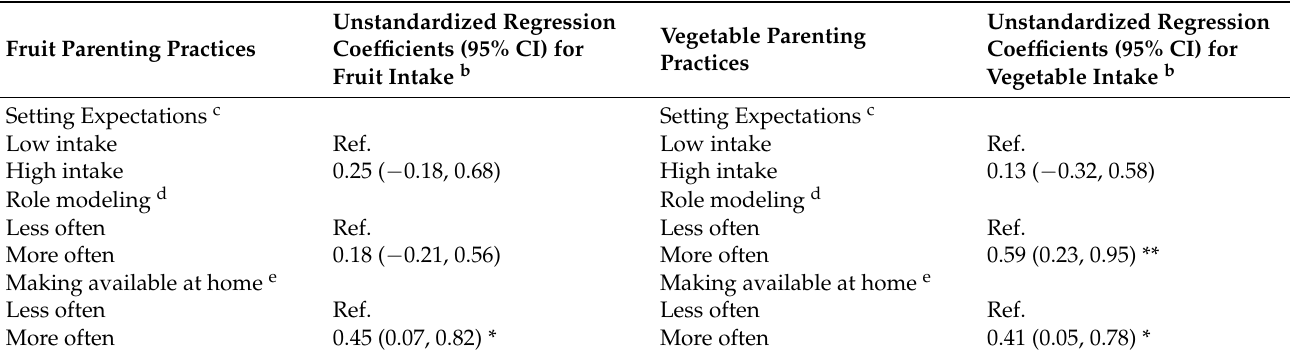
Table 2. Adjusted associations between adolescent-reported fruit and vegetable intake and fathers’ food parenting practices ( n = 191) a .